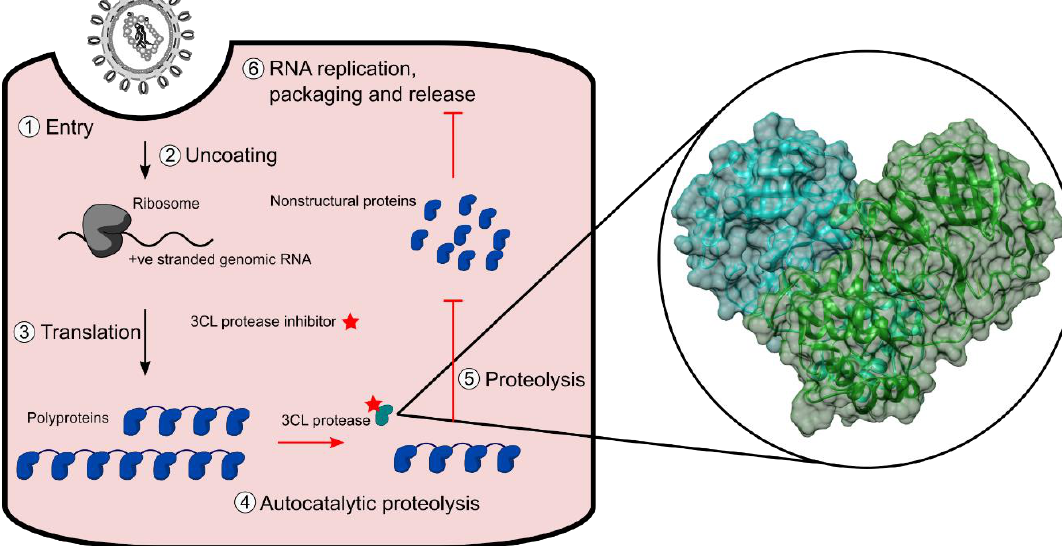
Figure 1. Schematic representation of the SARS-CoV-2 lifecycle in a host cell and the interruption by a 3CL pro inhibitor. The insert is the crystal structure of 3CL pro derived from PDB: 6M2Q .